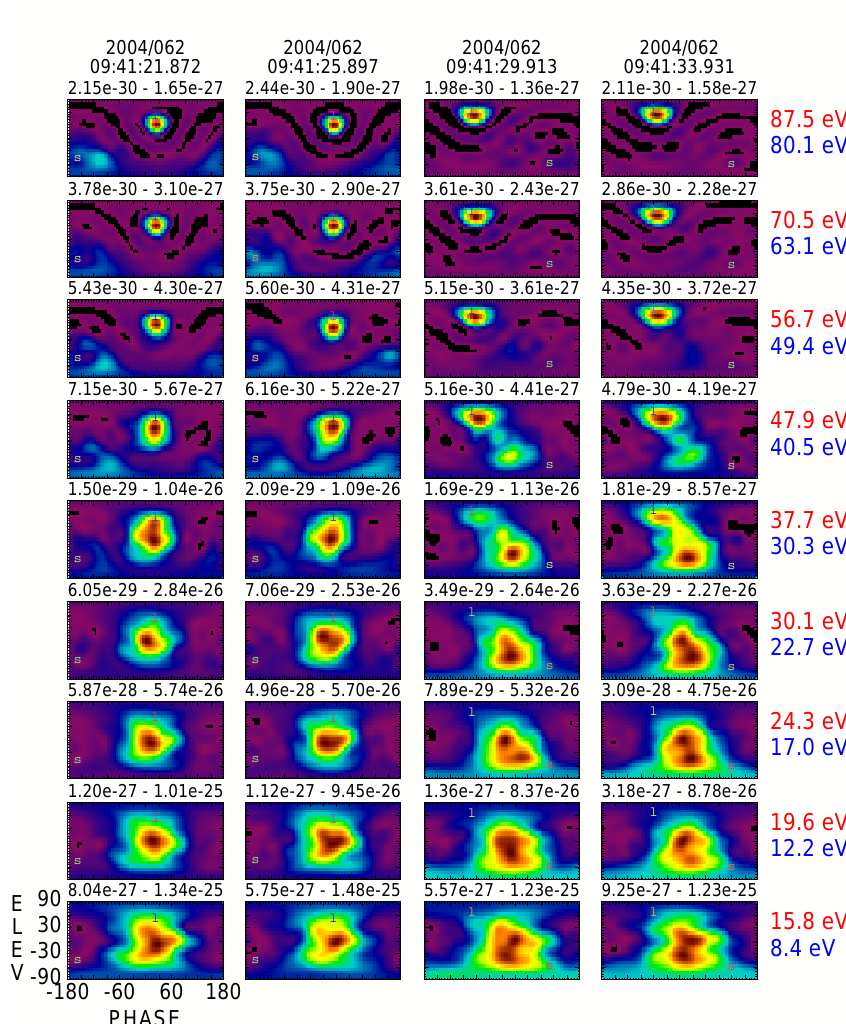
Fig. 3. A sets of PT plots from four successive eVDFs across the foreshock boundary. First two eVDFs were taken in the foreshock, as evidenced by the return electron population centered on the triangle. The last two eVDFs show scattering of the strahl beginning about 47.9eV. The scattering is seen as a tongue of particles extending from the strahl toward the opposite magnetic field projection. The enhanced electron population at the end of the tongue is what we have termed the